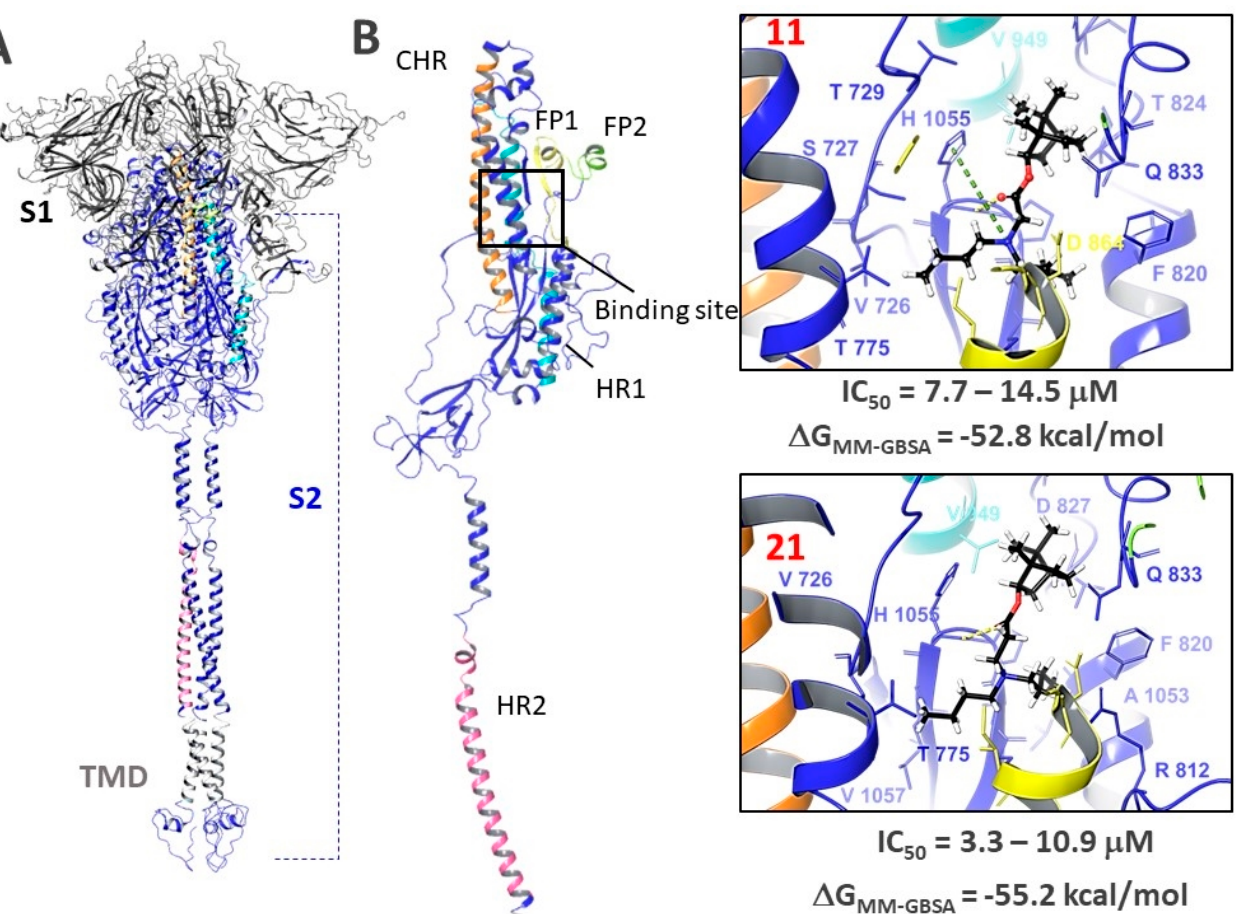
Figure 9. ( A )—full-length visualization of the surface protein: S1 and S2 surface protein subunits, TMD—transmembrane domain, CHR, HR1, HR2—central and heptad repeats 1 and 2, respectively, FP1, FP2—fusion peptides; ( B )—location of agents 11 and 21 in the supposed binding site: hydrogen bonds are shown with a yellow dashed line, π -cation interaction—with a green dashed line. The ranked IC 50 values illustrate the antiviral activity against different SARS-CoV-2 virus strains.